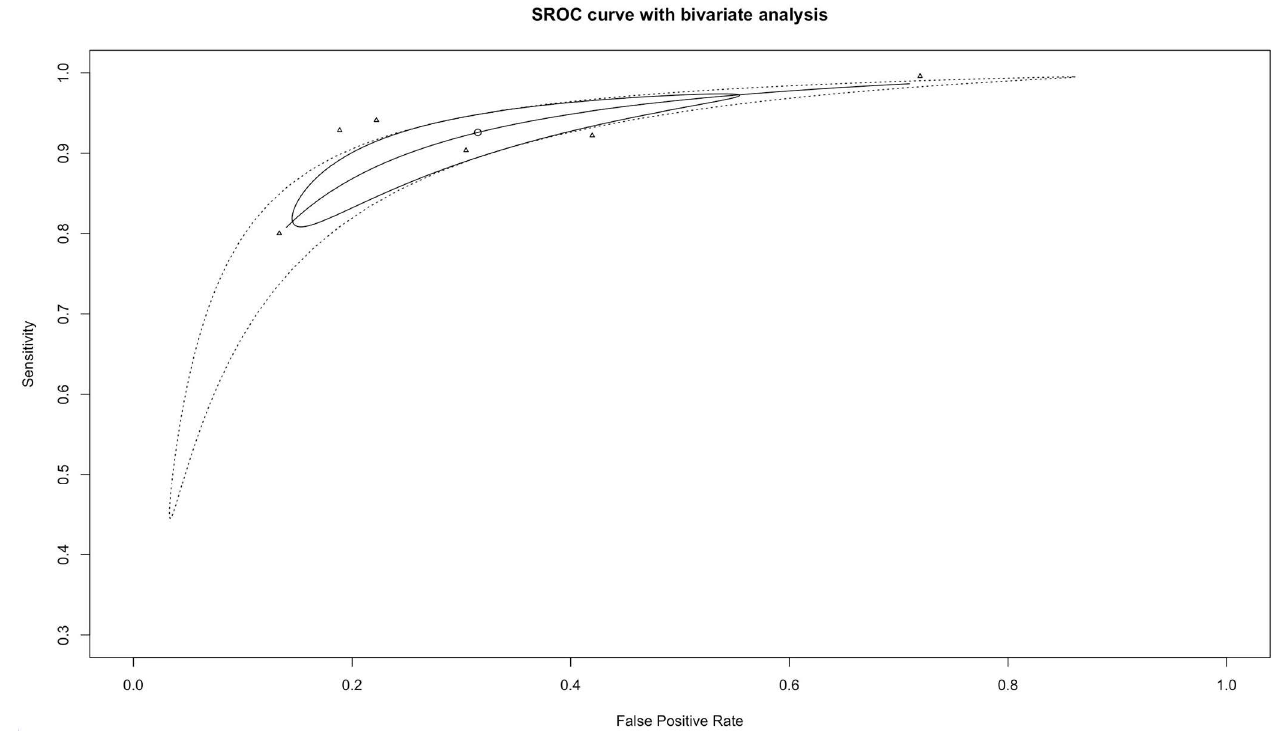
Figure 4. Summarized receiver-operating curves (SROC) using the bivariate approach.